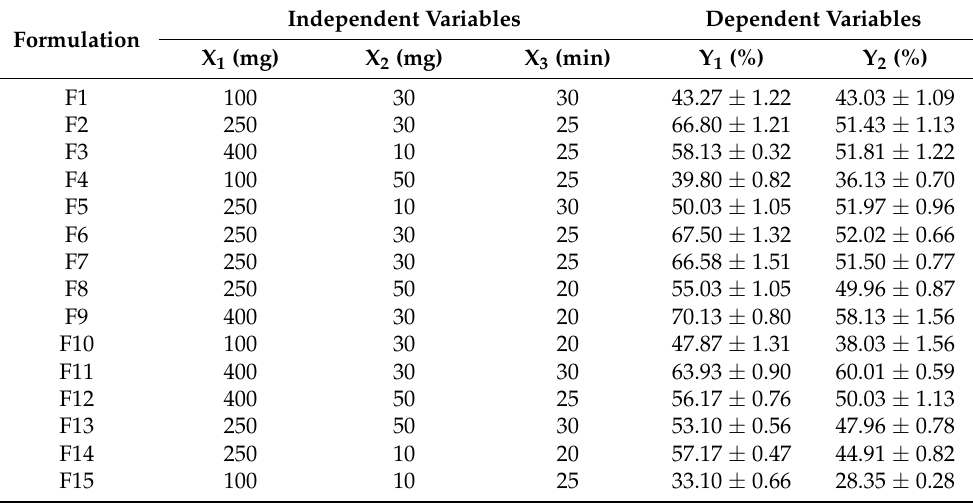
Table 2. The independent variables used for optimizing different transfersomal formulations and the detected results of dependent